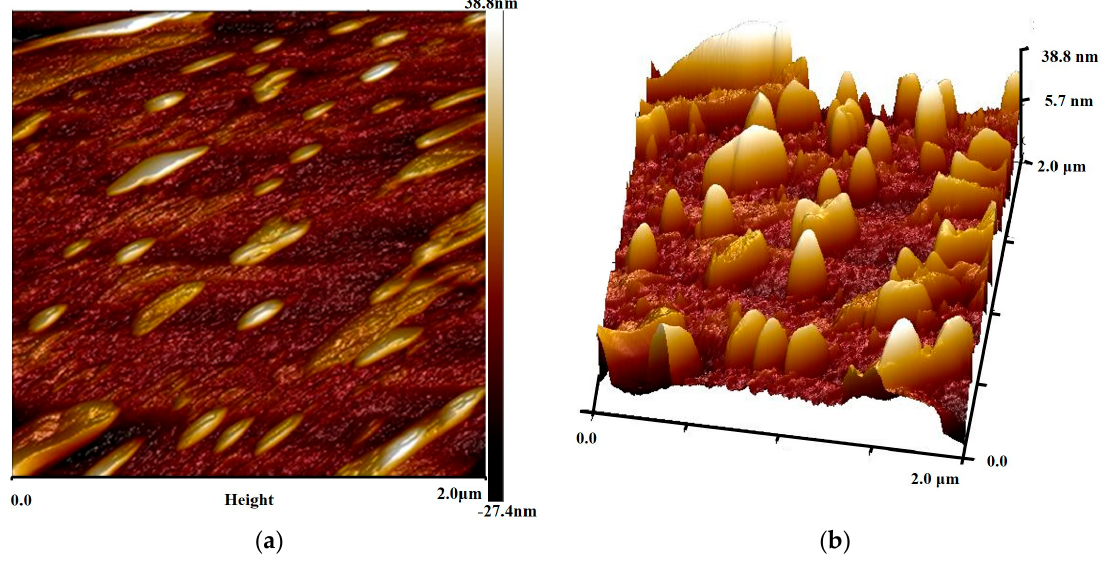
Figure 6. AFM ( a ) 2D and ( b ) 3D images of bacterial adsorption at 0.5 h.